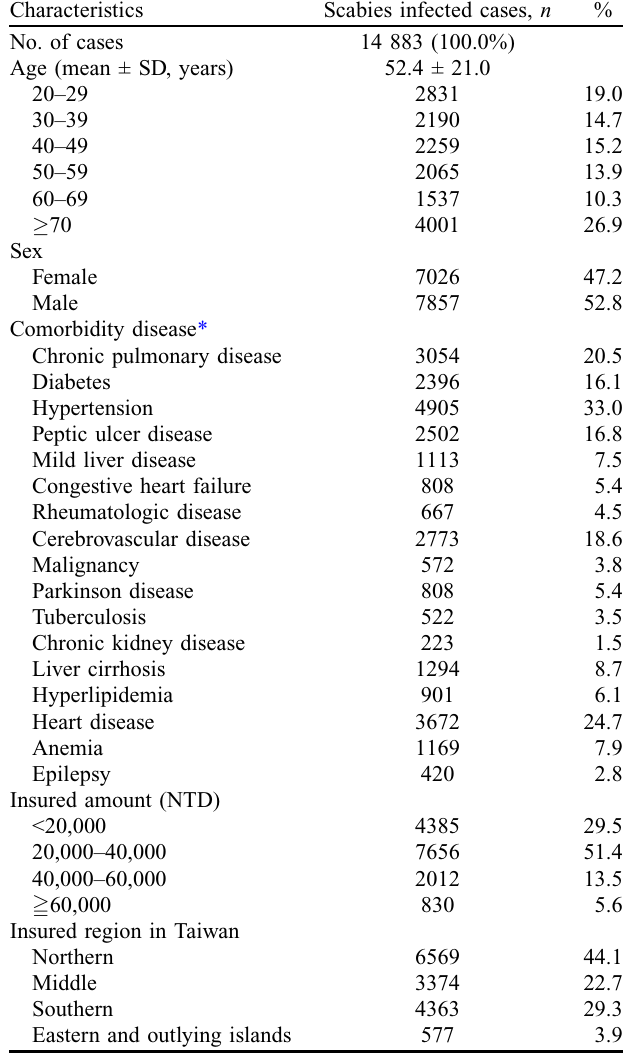
NTD = New Taiwan Dollar USD/TWD * 33.